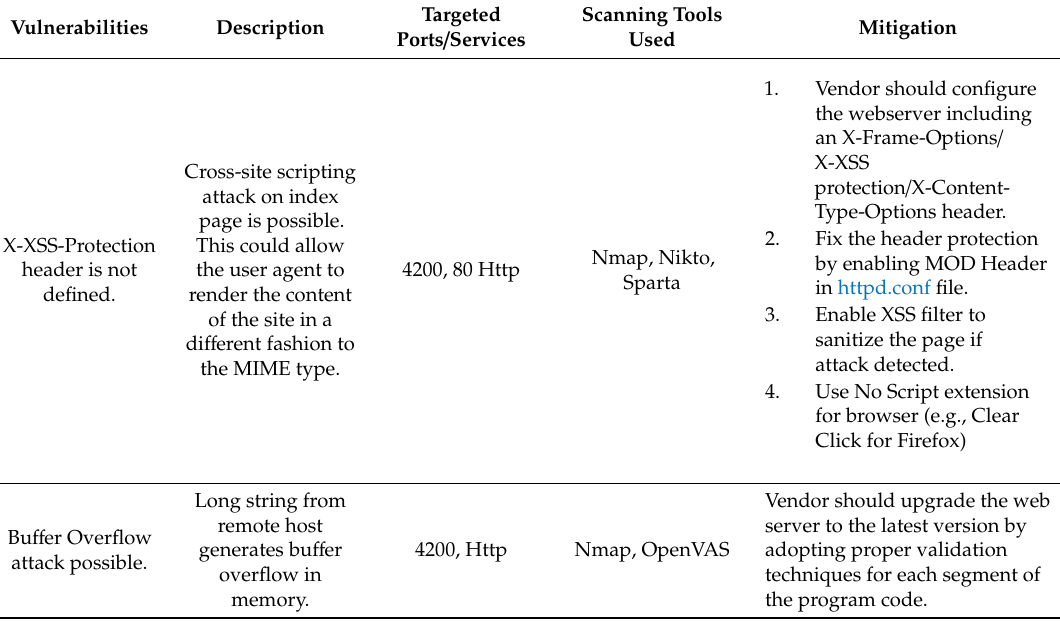
Table 1. Onion Omega2 vulnerability and mitigation (vendor